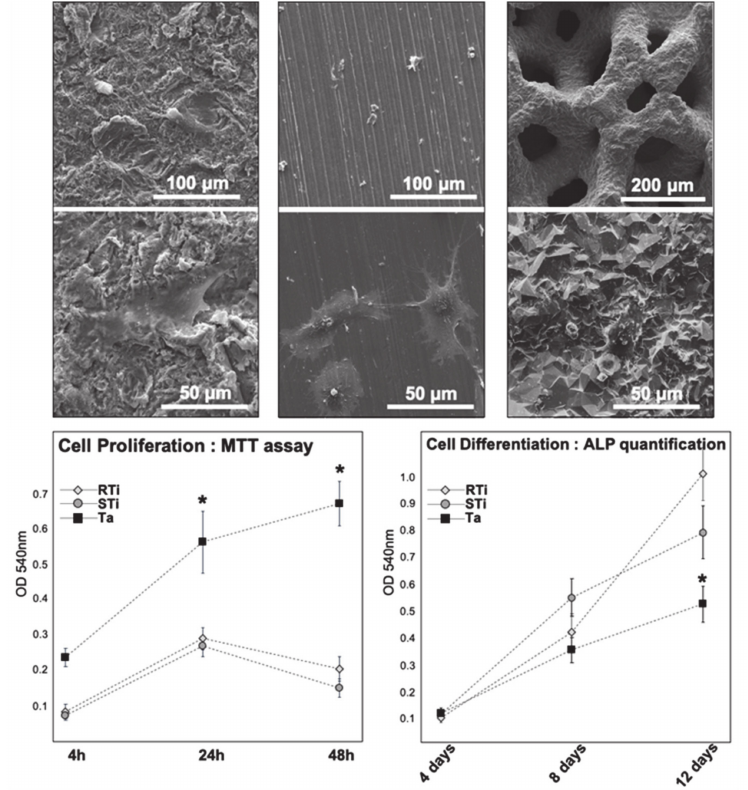
Figure 1. Scanning electron microscopy (SEM) images of dental pulp stem cells (DPSC) after 24 h of incubation, at a magnification × 400 and × 2000. From left to right: rough titanium (RTi), smooth titanium (STi), and tantalum (Ta). At higher magnification, spread and elongated cells are visible. Lower graphs: optical density from colorimetric assays (absorbance at 540 nm). Left graph: cell proliferation evaluation after 4 h, 24 h, and 48 h with MTT assays. Right graph: cell di ff erentiation evaluation after 4, 8, and 12 days with alkaline phosphatase (ALP) quantification. * indicates significant di ff erence ( p <